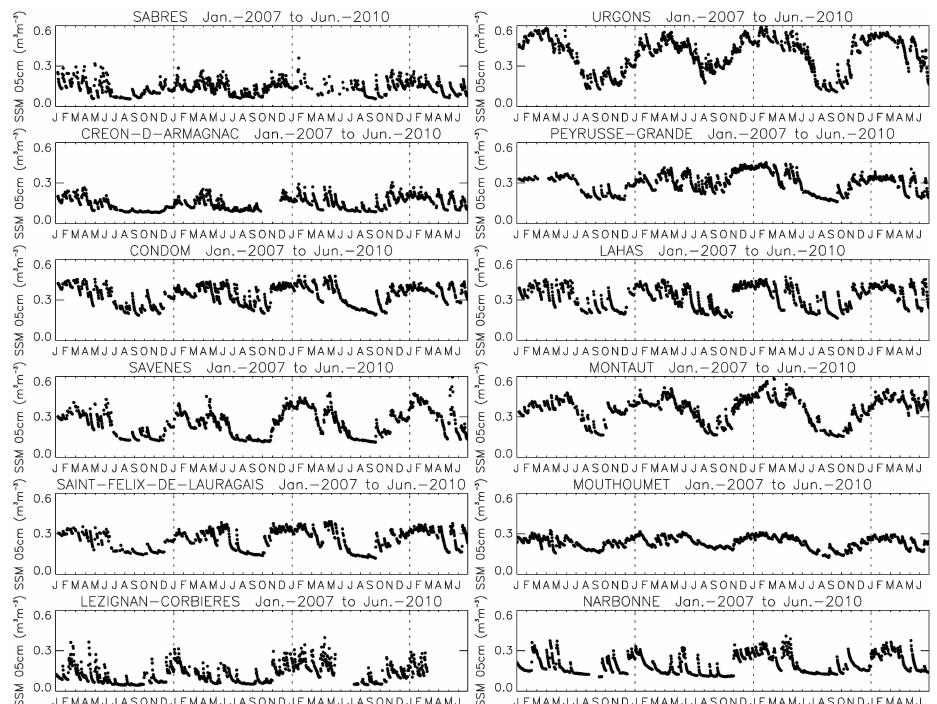
Fig. 1. Daily average 5cm (SSM) volumetric soil moisture content (m 3 m − 3 ) for the twelve stations of the SMOSMANIA network over a two year and six month period (January 2007–June